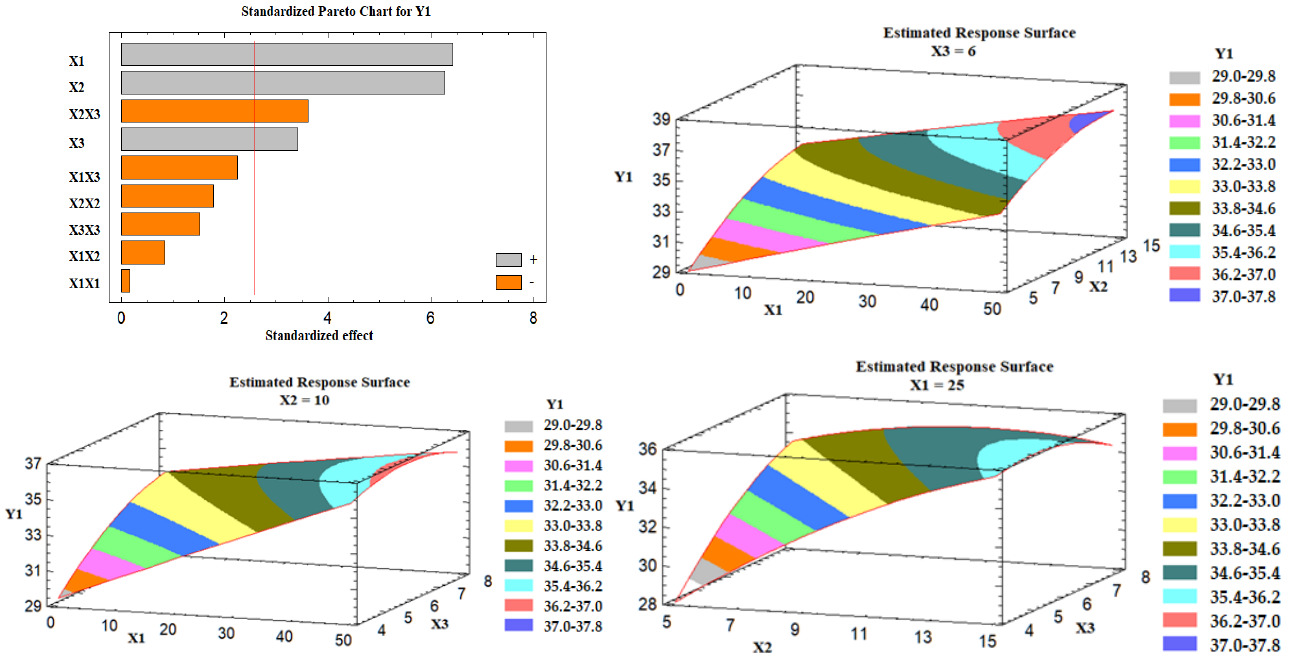
Figure 4. Pareto chart and estimated response surface plots for the effect of the studied factors on the angle of repose (Y1). Notes: X1; the carrier mixture, X2; the excipient ratio; X3; the percentage of superdisintegrant.